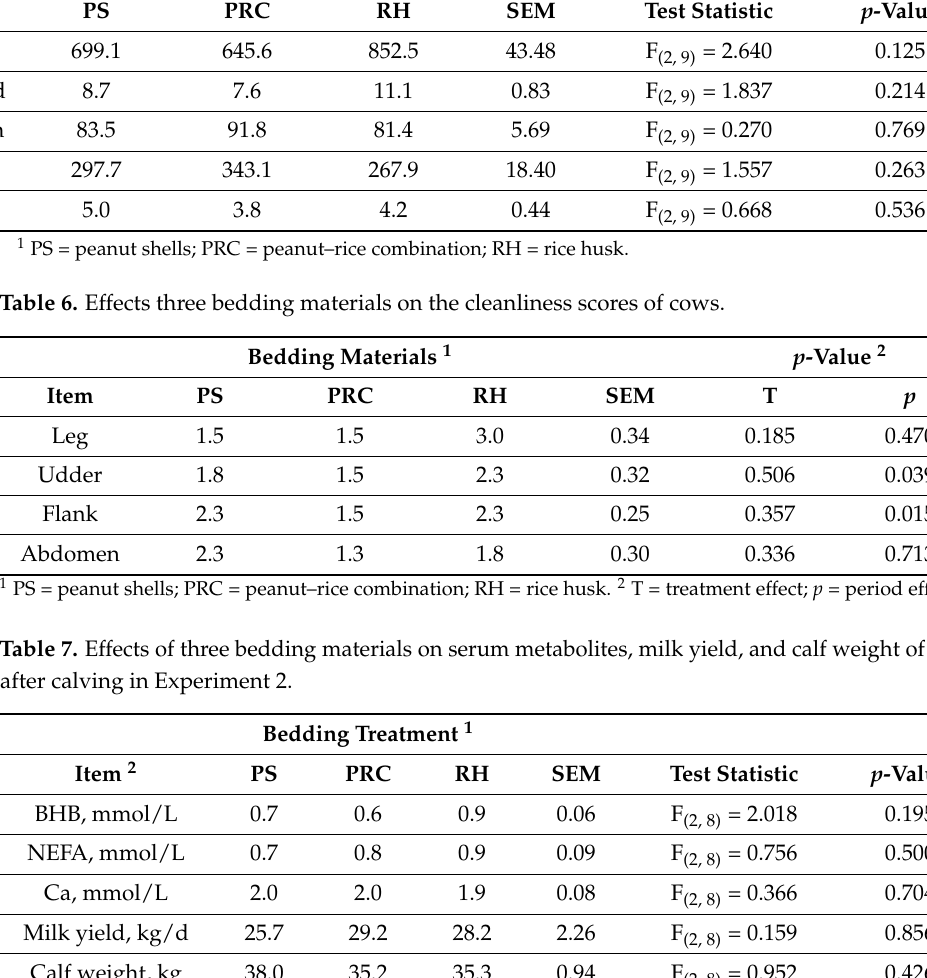
Table 5. Effect of three bedding treatments on lying and ingestive behaviour of dairy cows in Experiment 2. Bedding Treatment 1